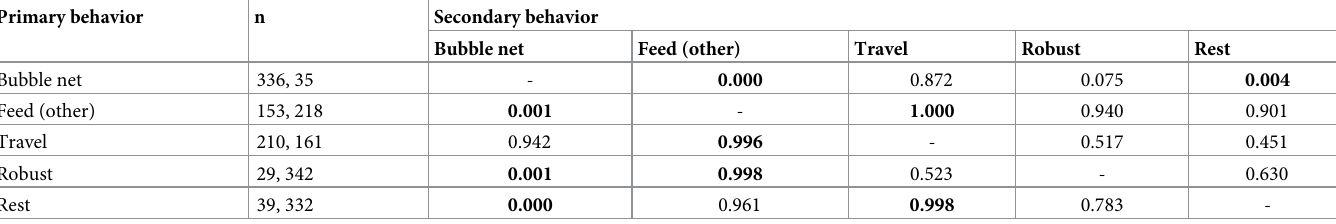
Table 4. Social transference of